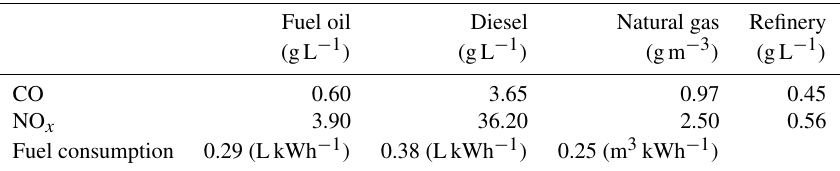
Table 3. Emission factors of CO and NO x for consumption of fuel oil, diesel, and natural gas in electricity production and refinery operations, obtained as median values from the US EPA (1998) (DeLuchi, 1993). The fuel consumption factor for electricity production is also listed (ELETROBRAS, personal communication, 2014).